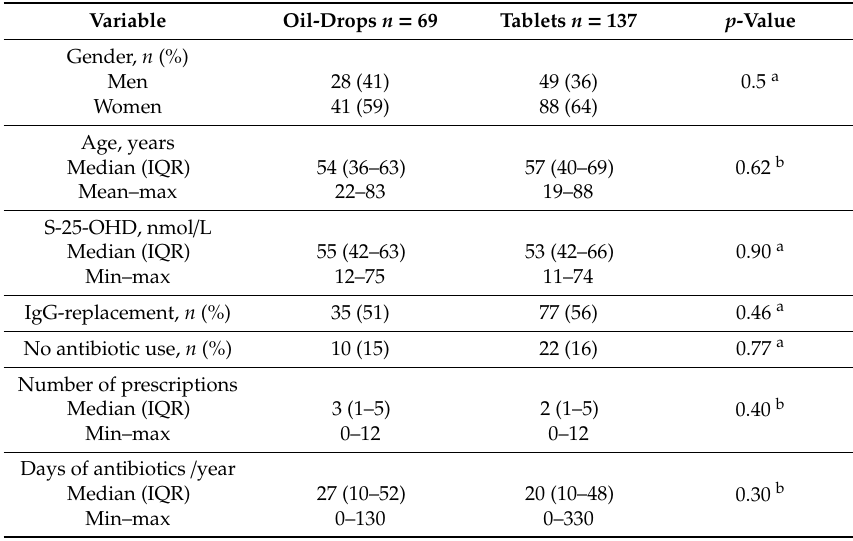
Table 1. Baseline demographics of the study population of immunodeficient patients who had been receiving vitamin D 3 supplementation as oil drops (1500 IE / day) or as tablets (1600 IE / day) for one year at the time of inclusion.